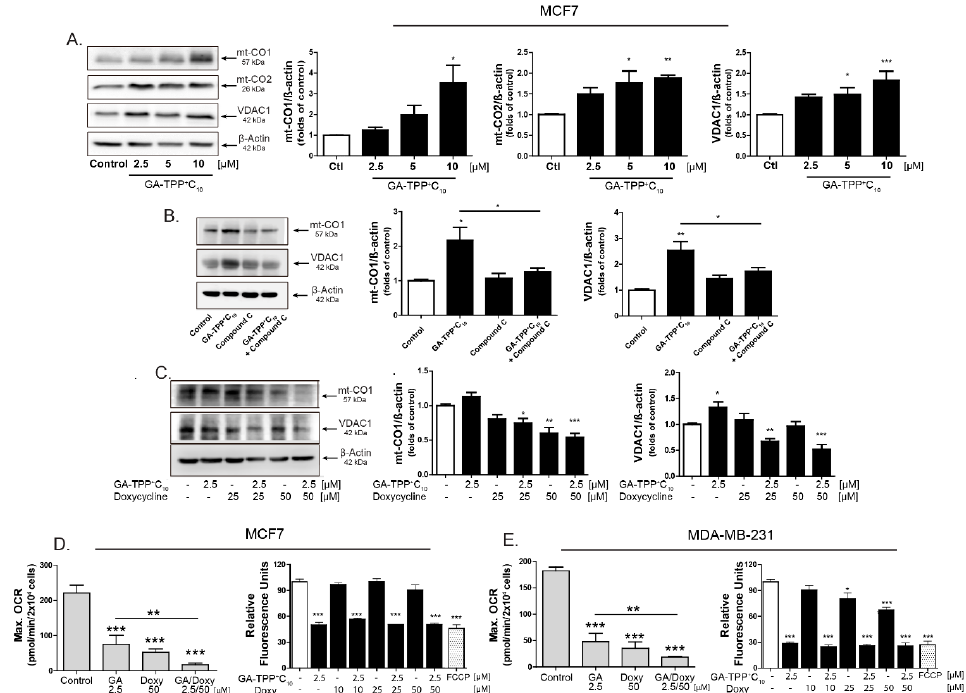
Figure 7. GA-TPP + C 10 and Doxy combination decreases mitochondrial function in BC cells. ( A ) Effect of GA-TPP + C 10 , ( B ) the AMPK inhibitor Compound C and (C) the GA-TPP + C 10 and Doxy combination on the mitochondrial protein levels of mt-CO 1 , mt-CO 2 , and VDAC after 24 h of exposure in MCF7 cells. ( C , D ) Effect of the combination on maximal OCR and ΔΨ m after 24 h of exposure in MCF7 and MDA-MB-231 cells. * p < 0.05, ** p < 0.01, *** p < 0.001 vs. the control (DMSO). Cells 2020 , 9 , x